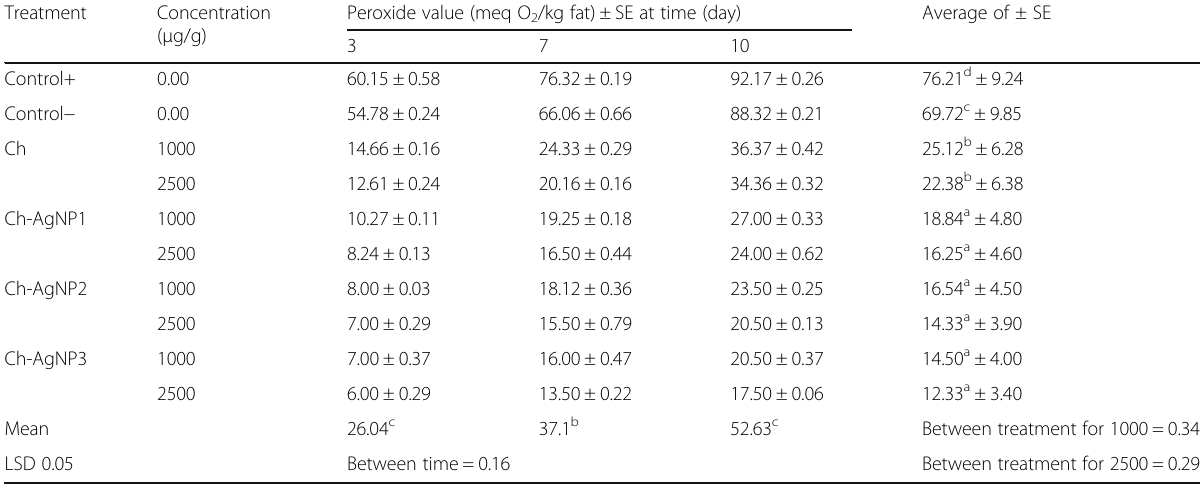
Between time = 0.16 Between treatment for 2500 = 0.297 Values are mean of three replicates ± standard error (SE). Different letters in the same column indicate significant differences according to Duncan's multiple range test ( P ≤ 0.05) Before treatment, 8meq O 2 /kg fat Control (+) minced meat treated with E. coli , Control ( − ) minced meat without E. coli , Ch chitosan, NP nanoparticle, Ch-AgNP1 (0.1% Ag), Ch-AgNP2 (0.2% Ag), Ch-AgNP3 (0.3%